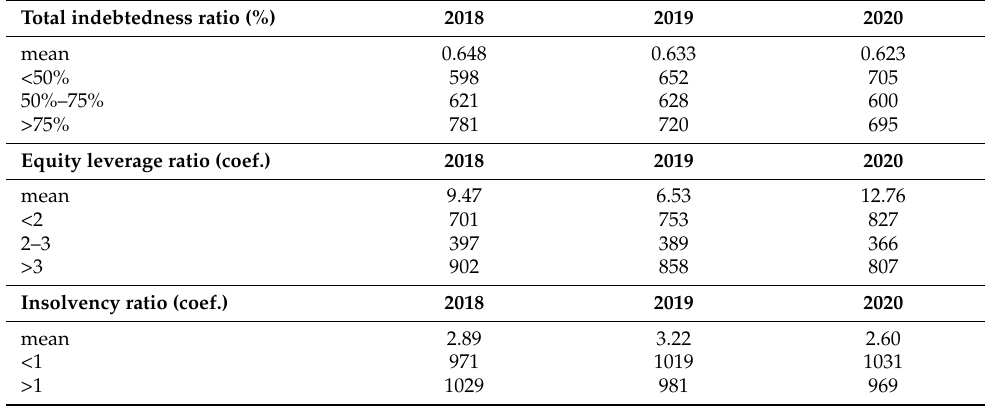
Table 7. Indebtedness ratios of the enterprises operating in the construction sector during 2018–2020. Total indebtedness ratio (%)